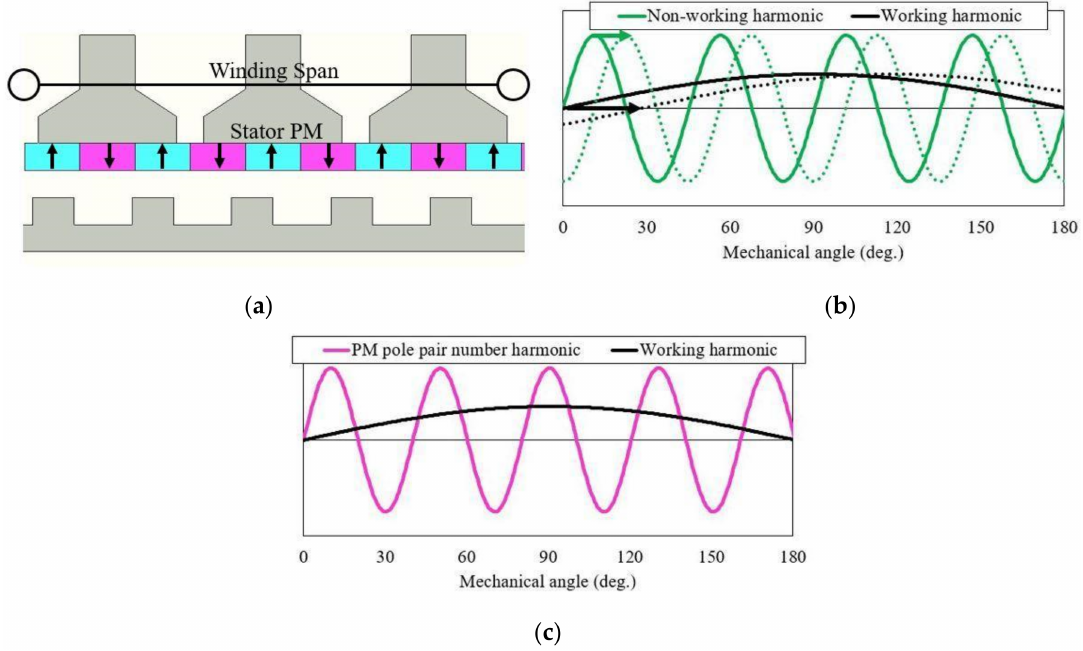
Figure 2. ( a ) Winding span. ( b ) Nonworking harmonic and working harmonic movement. ( c ) PM pole-pair-number harmonic with no